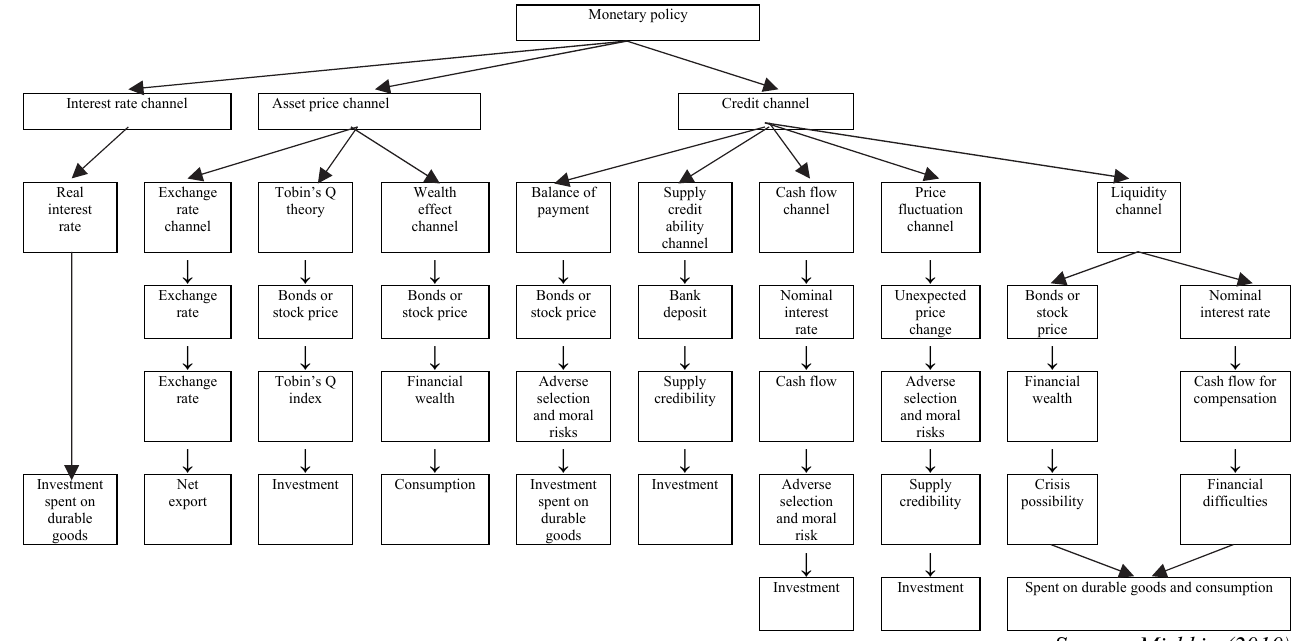
Fig. 3. The monetary transmission mechanism to economic of